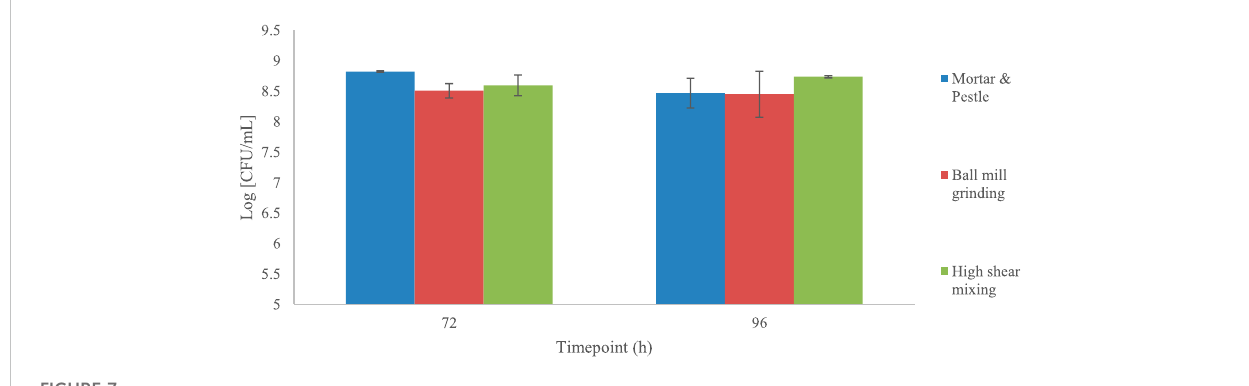
FIGURE 7 Concentration of B. subtilis cells cultivated on commercial Laminaria digitata fl akes undergone different mechanical pre-treatment methods and substrate composition. All samples were supplemented with 25 g/L sucrose and 10 g/L l-glutamic acid. Error bars indicate standard error (n =